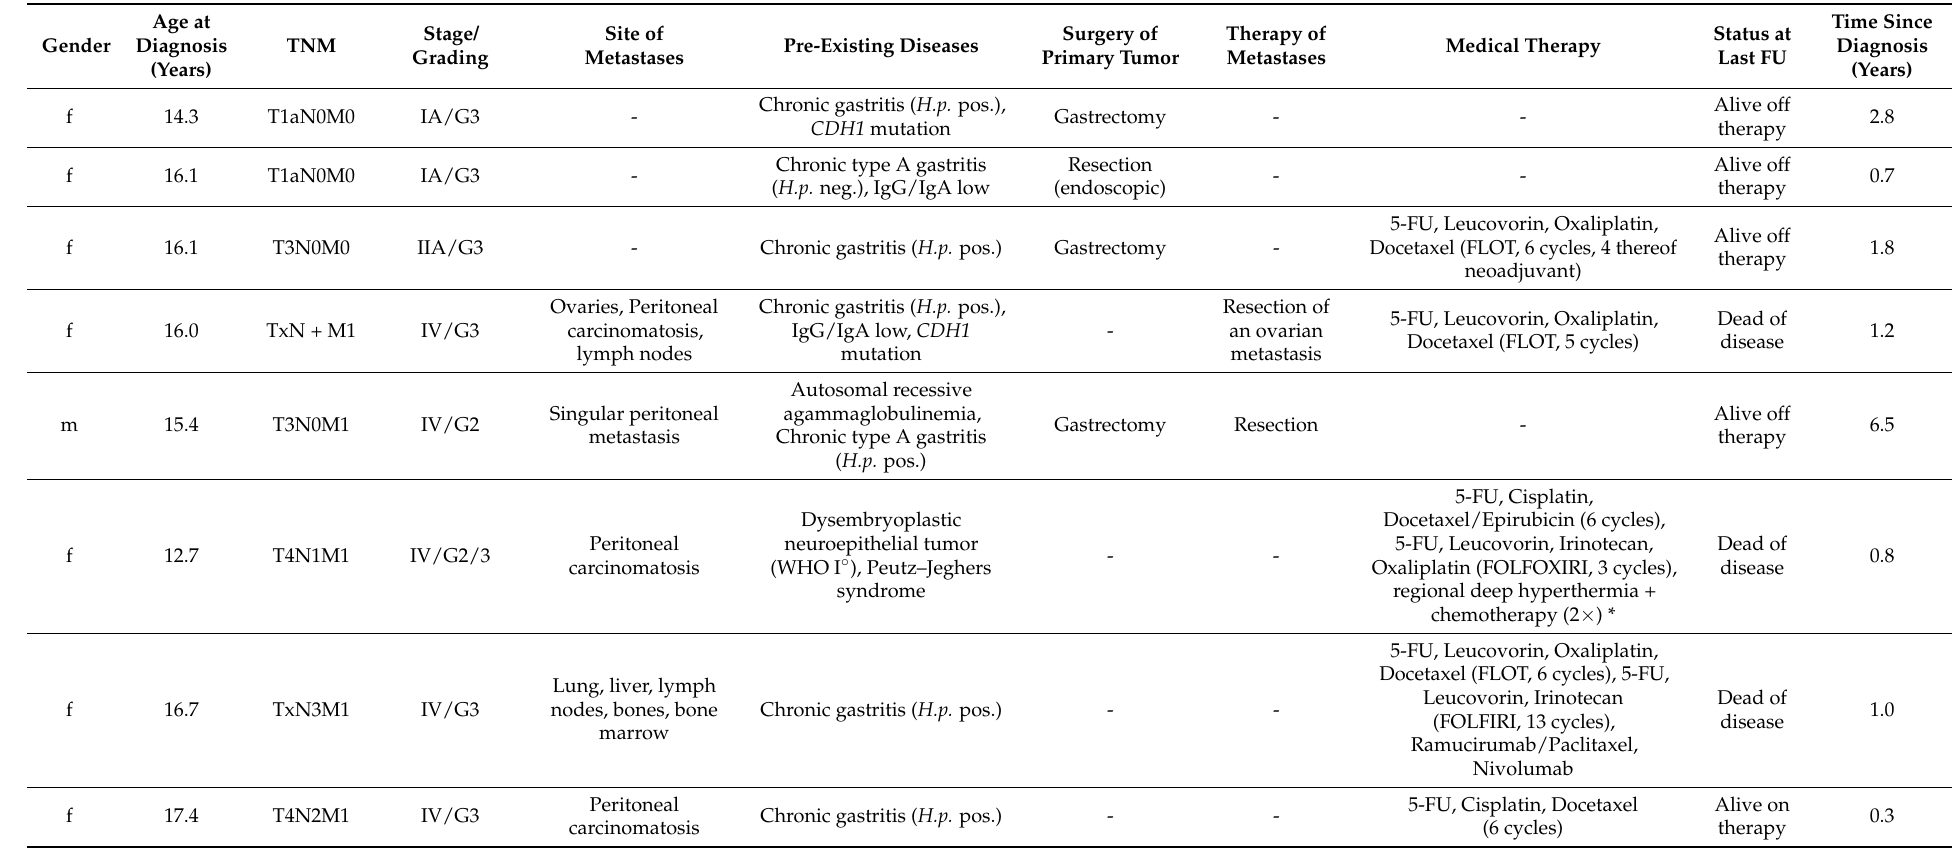
Table 4. Characteristics of pediatric patients with gastric carcinoma registered with the German Registry for Rare Pediatric Tumors (STEP). Abbreviations: H.p.